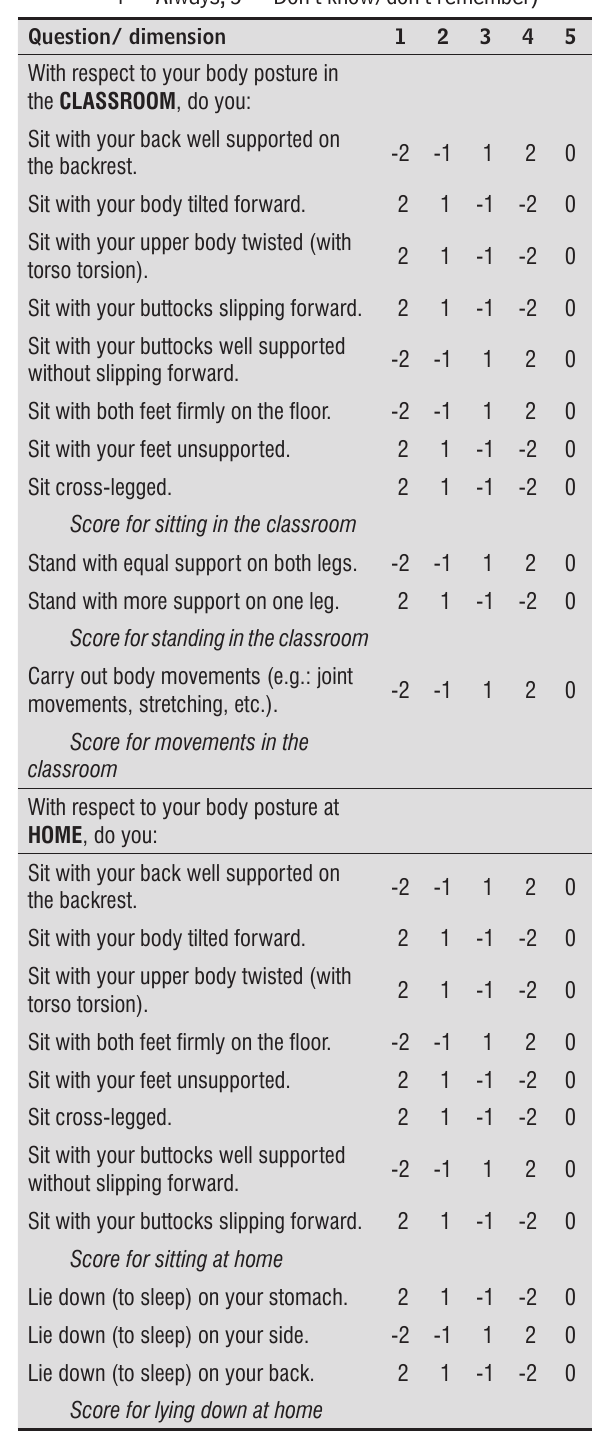
Table 4 - Questionnaire on body awareness and postural habits of young people and the respective values for the alternatives (1 = Never; 2 = Rarely; 3 =